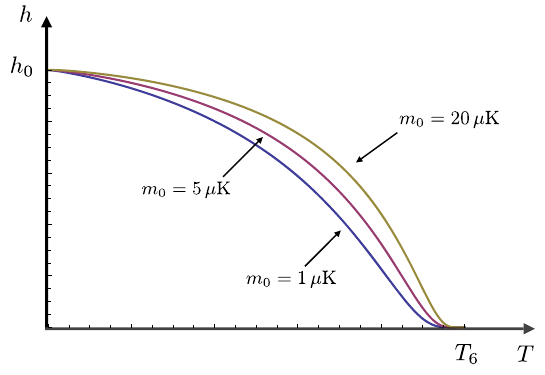
FIG. 3. Interlayer separation h ð T Þ as a function of temperature, based on Eq. (4.9). The zero-temperature value, h 0 , is of order 1 micron, as shown in Eq. (4.4). Note that the functional form of h ð T Þ is sensitive to the value of m 0 , even at temperatures well above m 0 itself. Throughout, the onset temperature for clock order is taken to be T 6 ¼ 10